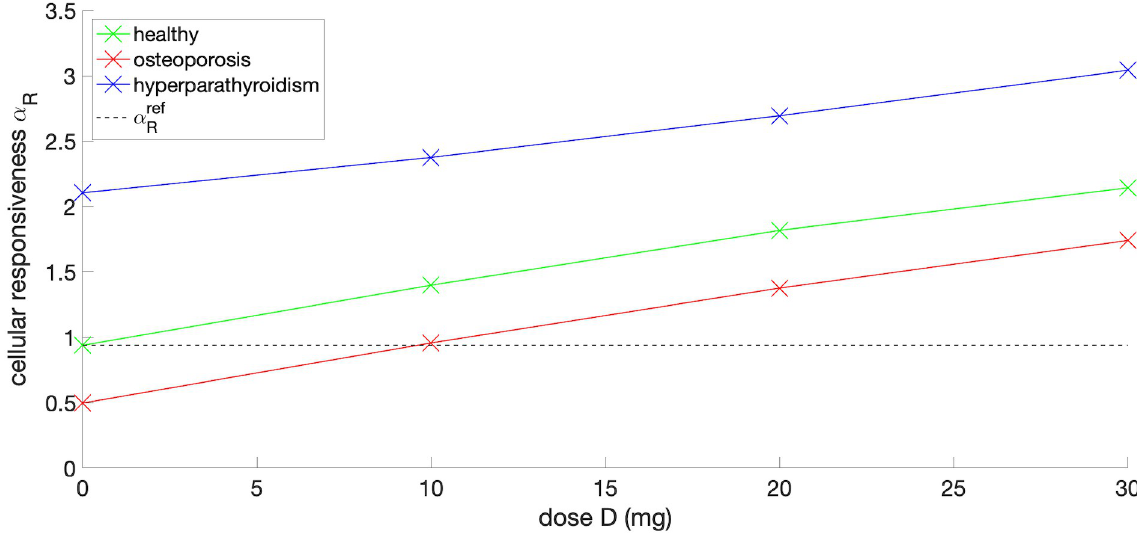
Fig 7. Cellular responsiveness computed with model 2 for healthy person, patients with idiopathic osteoporosis and hyperparathyroidism after different doses of PTH sc injection are applied once